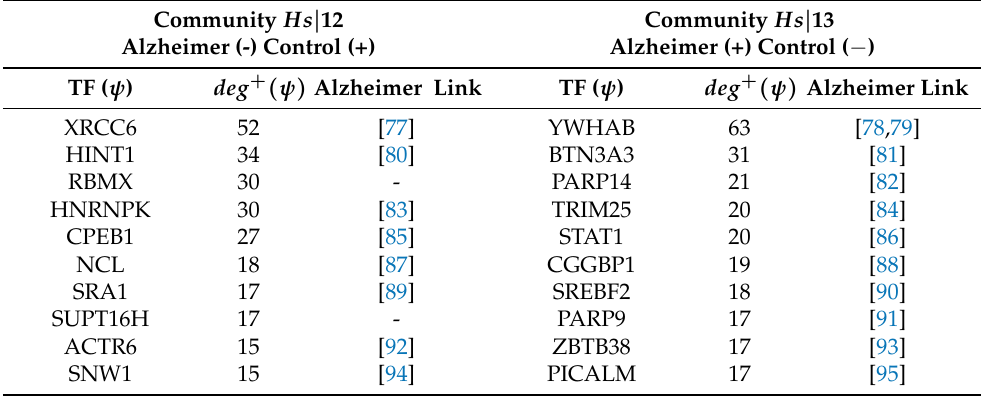
Table 4. Out-degree and possible relations to Alzheimer disease in the literature, for the top-10 TFs from communities Hs | 12 (over-expressed in control and under-expressed in Alzheimer) and Hs | 13 (under-expressed in control and over-expressed in